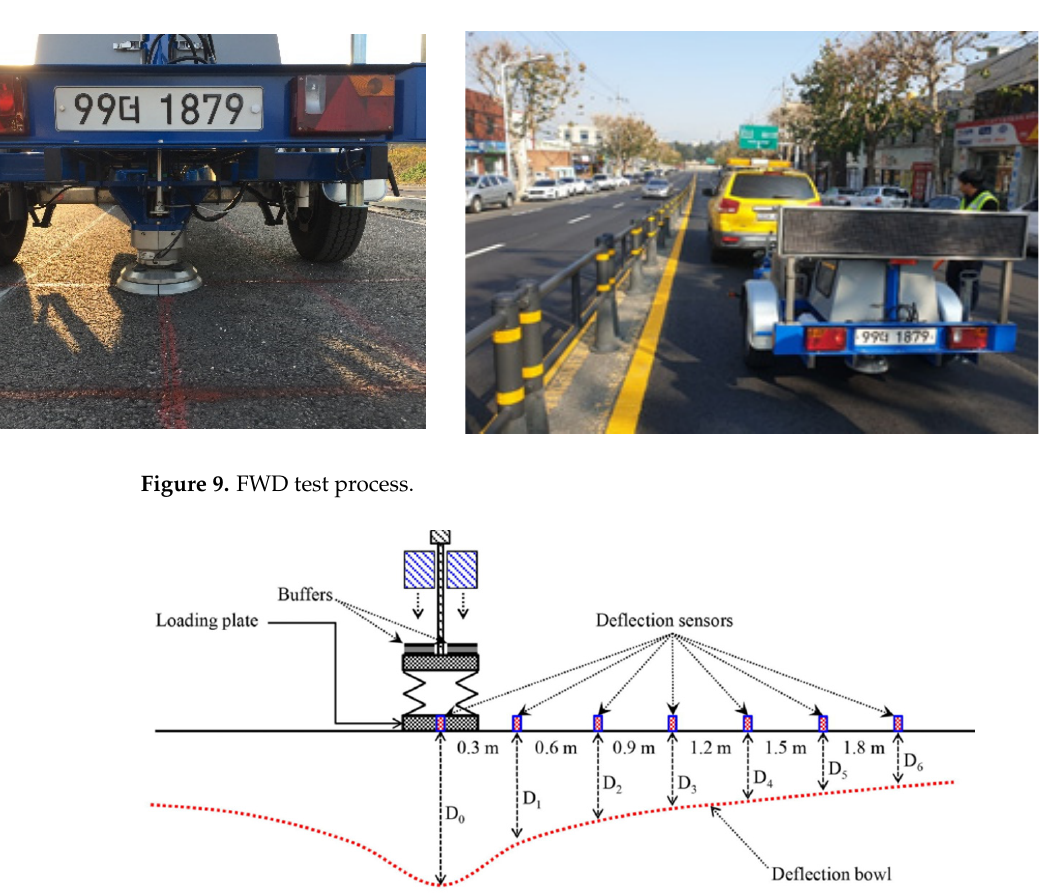
Table 8. Parameters for the functional level of the